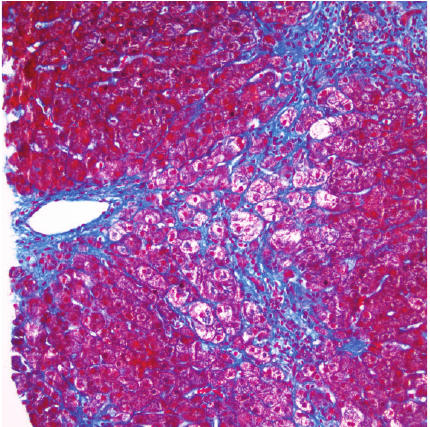
Figure 4: Prominent perisinusoidal fibrosis and ballooned hepato- cytes with Mallory-Denk bodies